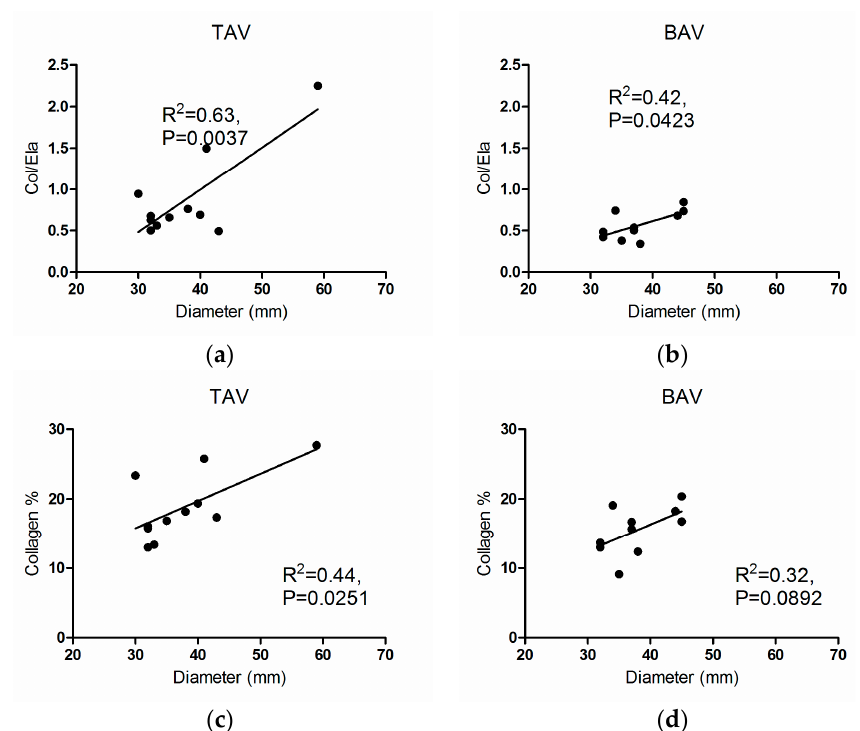
Figure 6. Col/Ela with respect to diameter for ( a ) the TAV; and ( b ) the BAV groups; collagen with respect to diameter for ( c ) the TAV; and ( d ) the BAV groups.